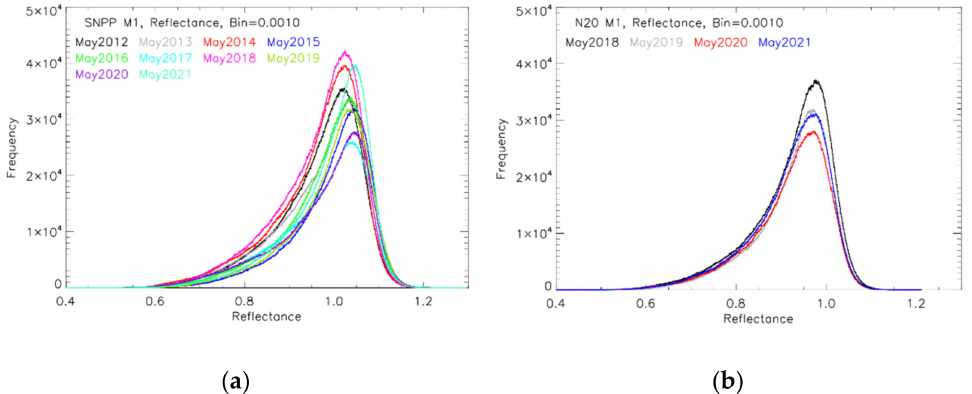
Figure 3. Monthly DCC PDF in reflectance for SNPP ( a ) and NOAA20 ( b ) VIIRS M1 band. The month of May each year is selected for the two VIIRS sensors,